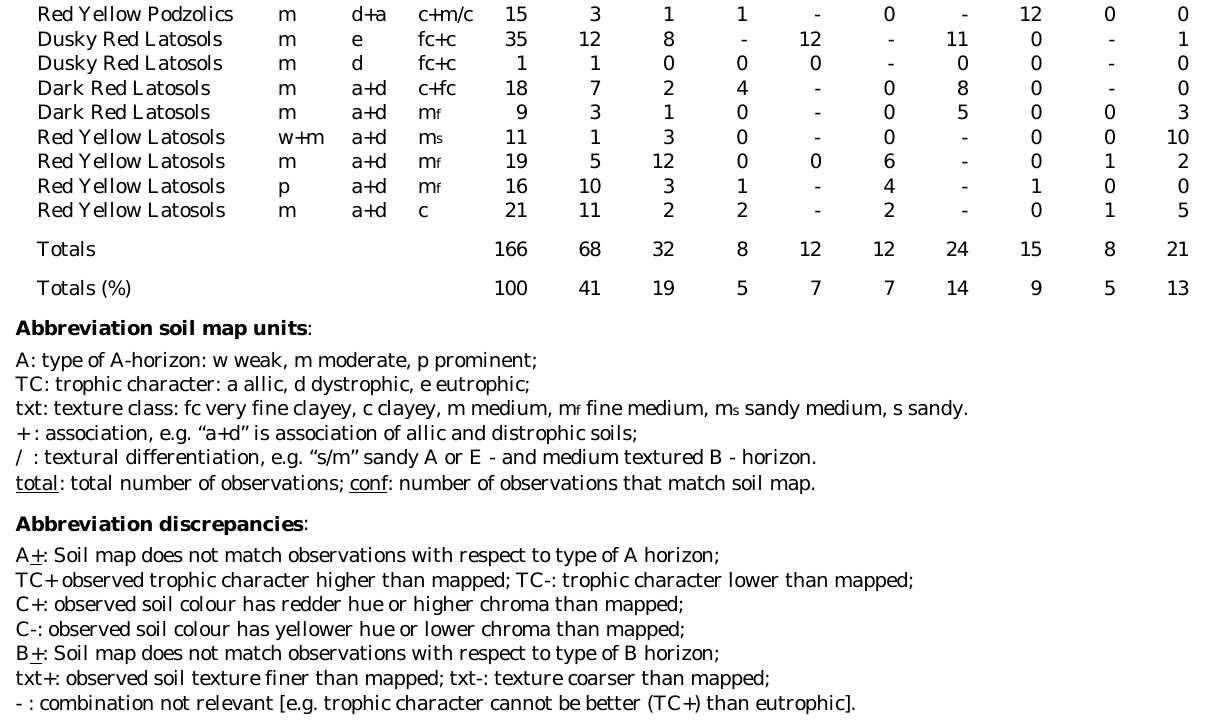
Table 2. Purity analysis for Araras Soil map unit Hierarchical levels